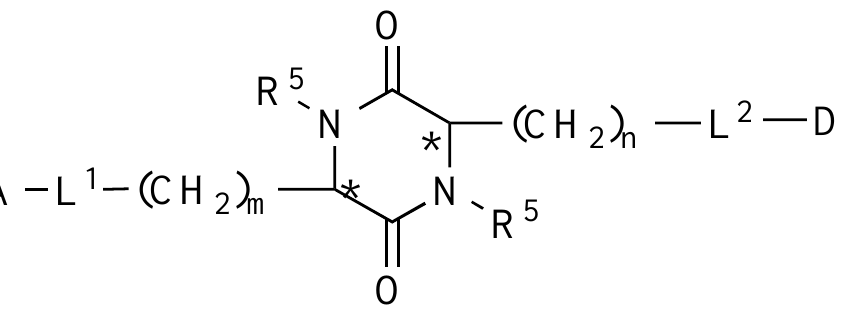
Figure 4. The general formula of a platform for synthesizing libraries of peptidomimetics based on substituted 2,5-DKP. A and D represent biologically active pharmacophores or fragments of peptide compounds; L 1 and L 2 are biodegradable linkers; m and n are the number of CH 2 groups (ranging from 0 to 4); and R 5 represents possible derivatives of the pharmacophore attached at the nitrogen atoms. * Denotes regions where the S or R optical orientation is possible at the carbon atoms at positions 3 and 6.